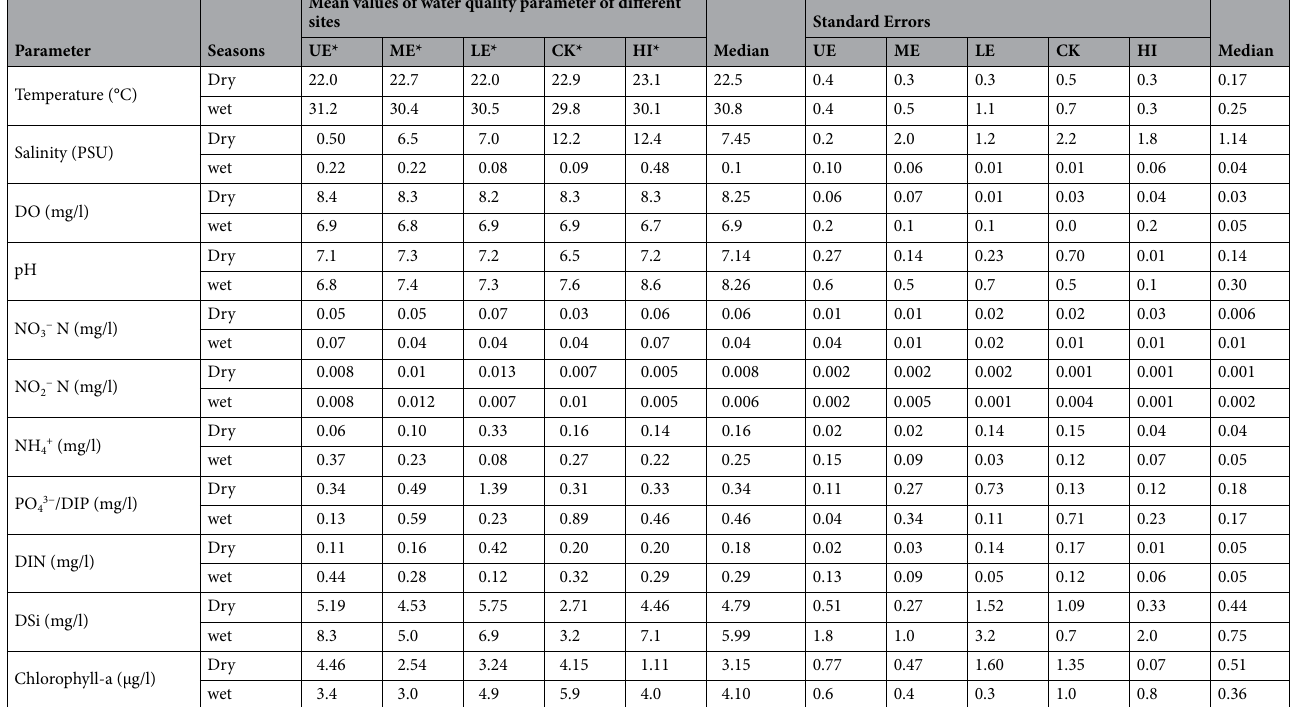
Table 1. Median and standard errors of physical, chemical and biological parameters in different sections of the MRE during dry and wet